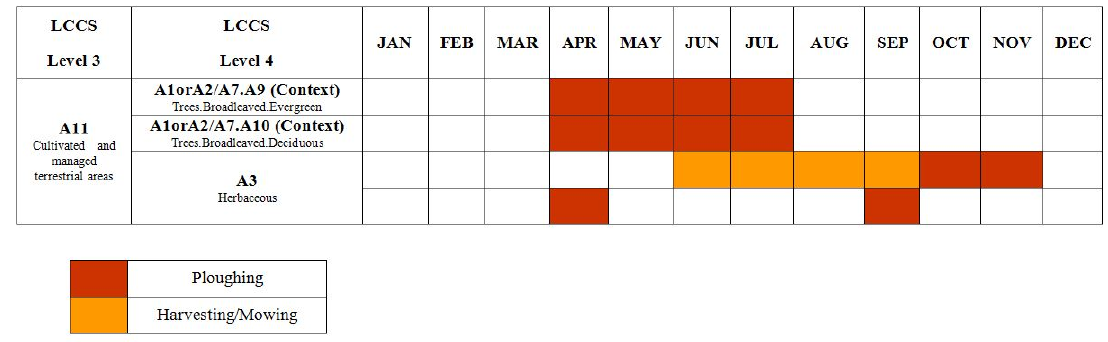
Figure 3. Agricultural practices characterizing cultivated and managed classes in Murgia Alta.